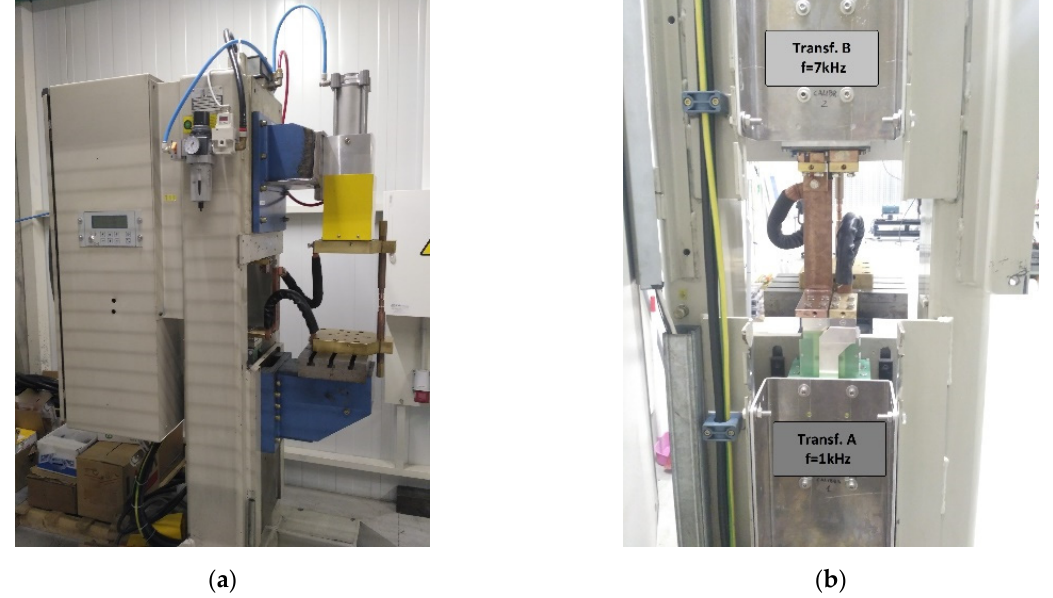
Figure 2. Welding equipment: ( a ) side view; ( b ) the arrangement of the transformers.